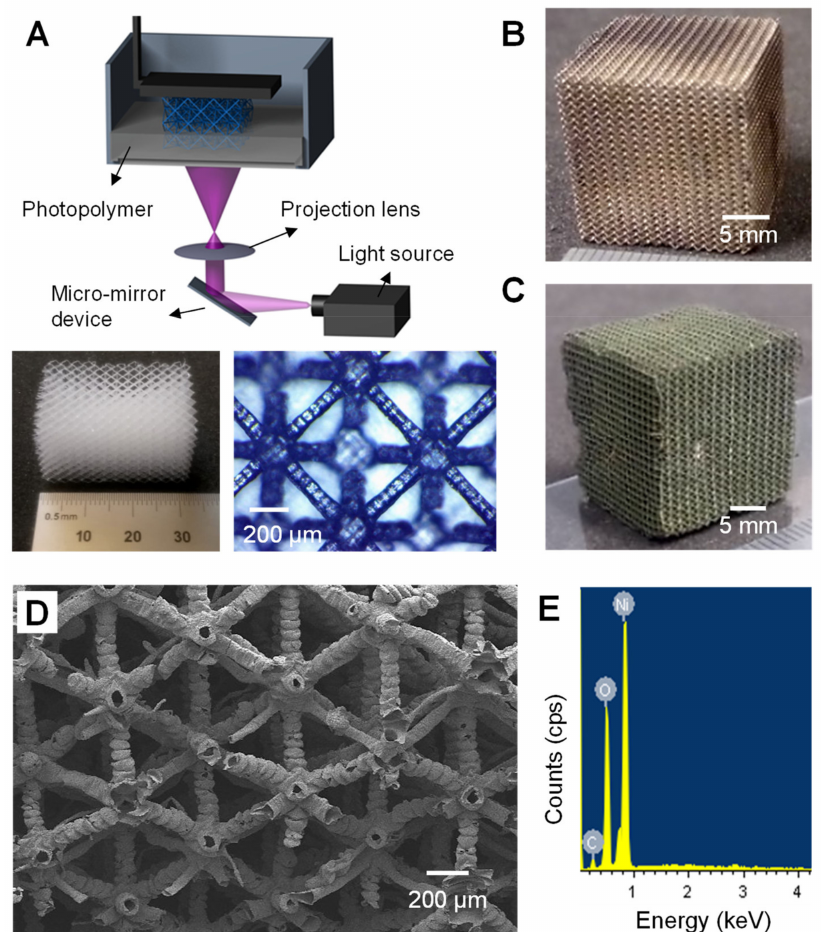
Figure 2. Fabrication of the microlattice with hollow-tube networks. ( A ) Polymeric microlattice fabricated by DLP 3D printing process. ( B ) Solid Ni-P/polymer composite microlattices ( d * = 0.08). ( C ) NiO-based hollow-tube ceramic microlattices ( d * = 0.08 and t * = 0.1). ( D ) Magnified views of the hollow-tubes of the ceramic microlattices. ( E ) Measured EDS of the hollow-tube NiO